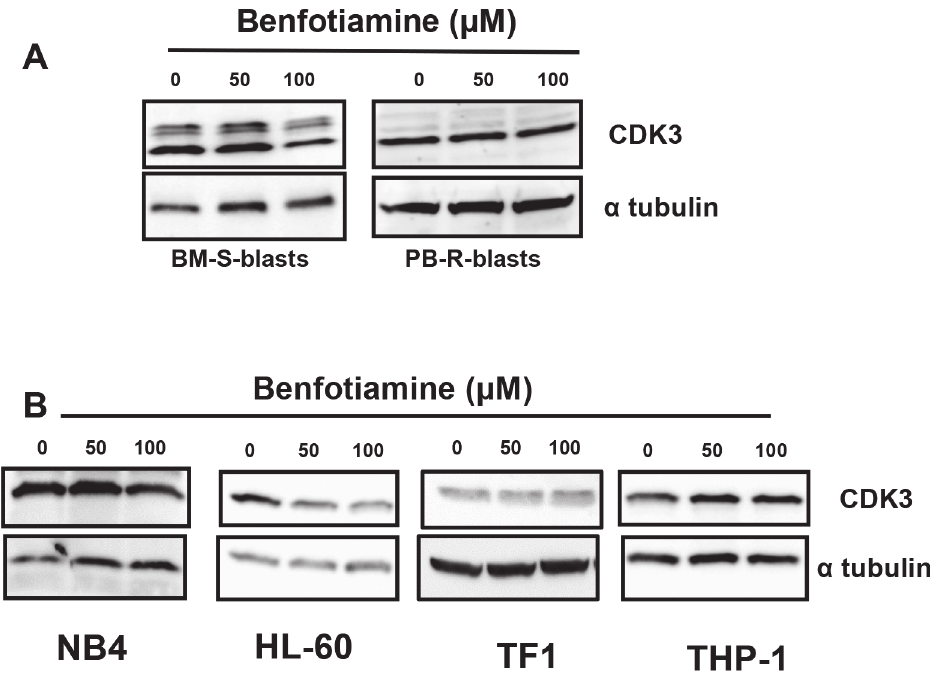
Fig 5. Modulation of CDK3 expression by benfotiamine. BM-S-blasts and PB-R-blasts (A) NB4, HL-60, THP-1 and TF1 cells (B) were cultured for 24 hours in the presence or absence of benfotiamine and the expression of CDK3 was analyzed via Western blotting. Representative results of three independent experiments are